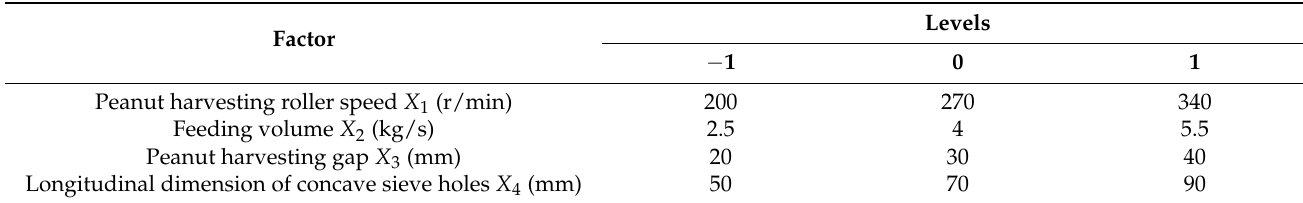
Table 2. Factors and levels of test.